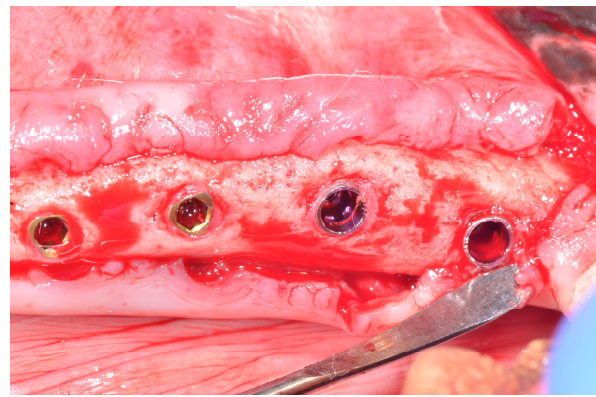
Figure 2. The implantation protocol was 4 implants per hemi-mandible.